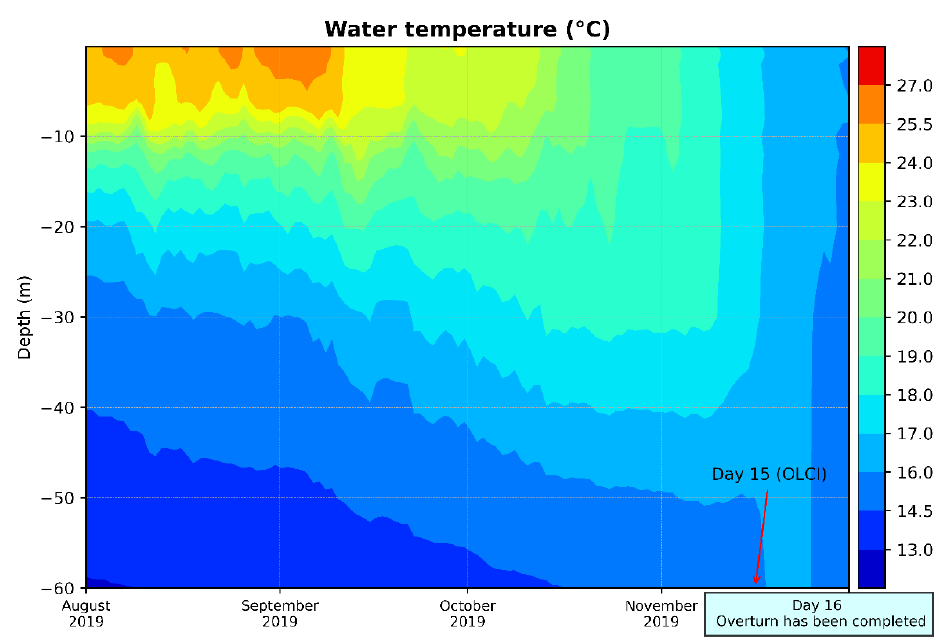
Figure 10. Temperature profile from August to November (2019).